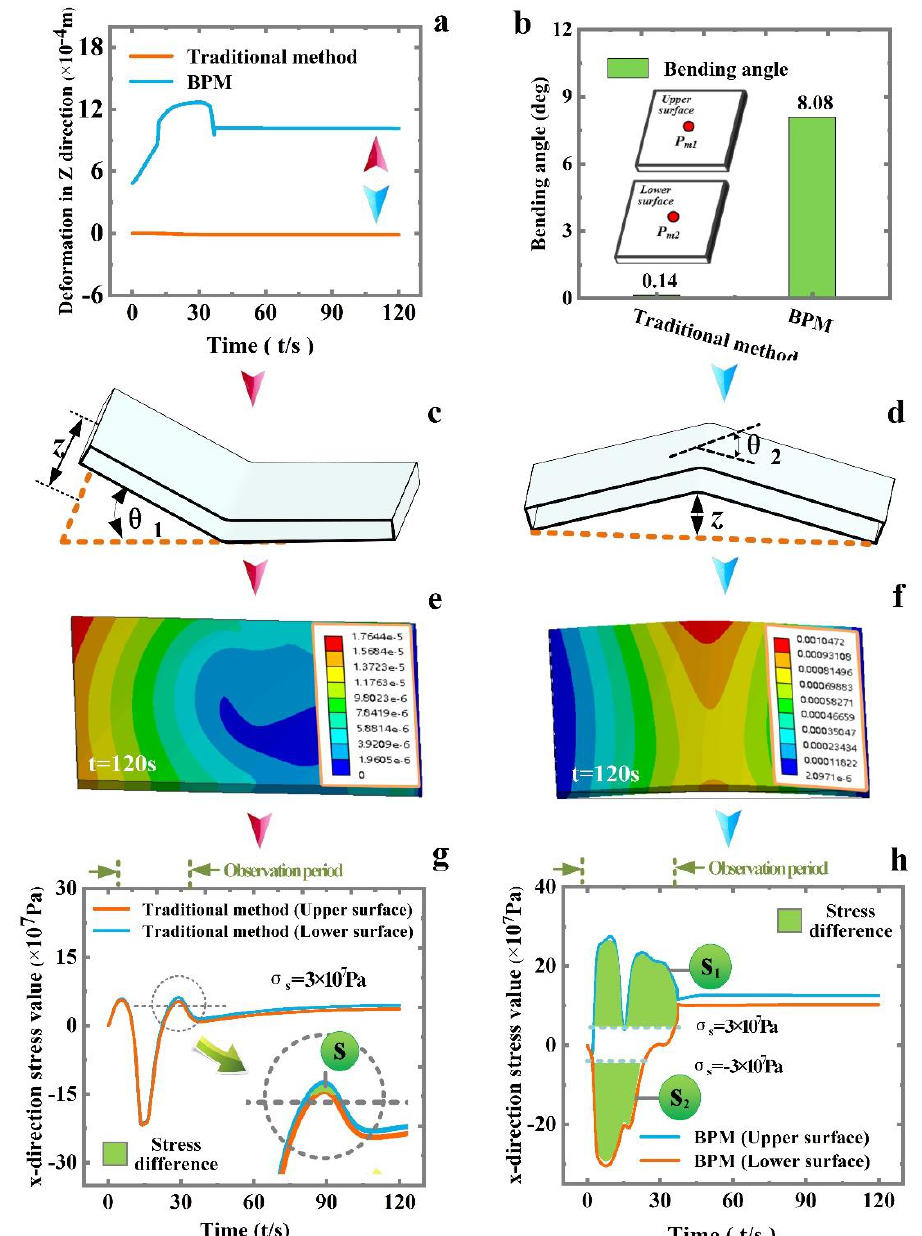
Figure 8. Comparison of traditional method and BPM. ( a ) z-directional deformation, ( b ) bending angle and measurement point, ( c ) bending form (traditional method), ( d ) bending form (BPM), ( e ) cloud diagram (traditional method), ( f ) cloud diagram (BPM), ( g ) stress value (traditional method) and ( h ) stress value (BPM).